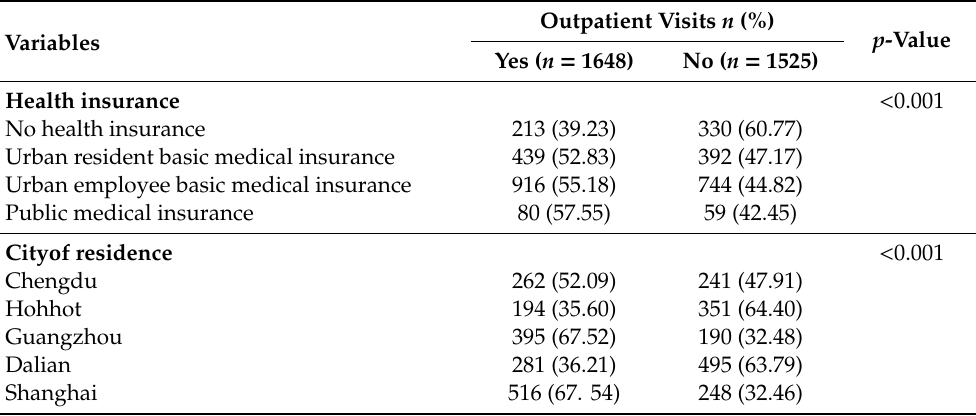
Table 2. Health insurance and city of residence by outpatient